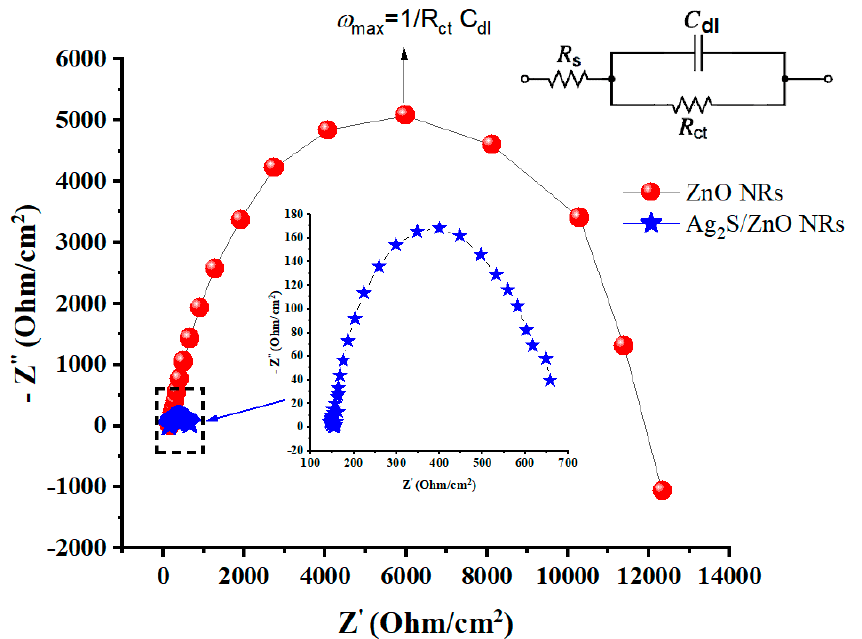
Figure 9. Nyquist plots (real Z vs. imaginary Z) of plain ZnO NRs and optimal Ag 2 S/ZnO NRs with concentrations of 0.005 M of AgNO 3 and 0.03 M of CS(NH 2 ) 2 . The inset is the simplified Randle circuit model employed to fit the Nyquist plot. ω max = 2 π f max is angular frequency, R s is solution resistance, R ct is charge transfer resistance, and C dl is double-layer capacitance. Table 3. Impedance spectroscopy analysis of photoanodes.